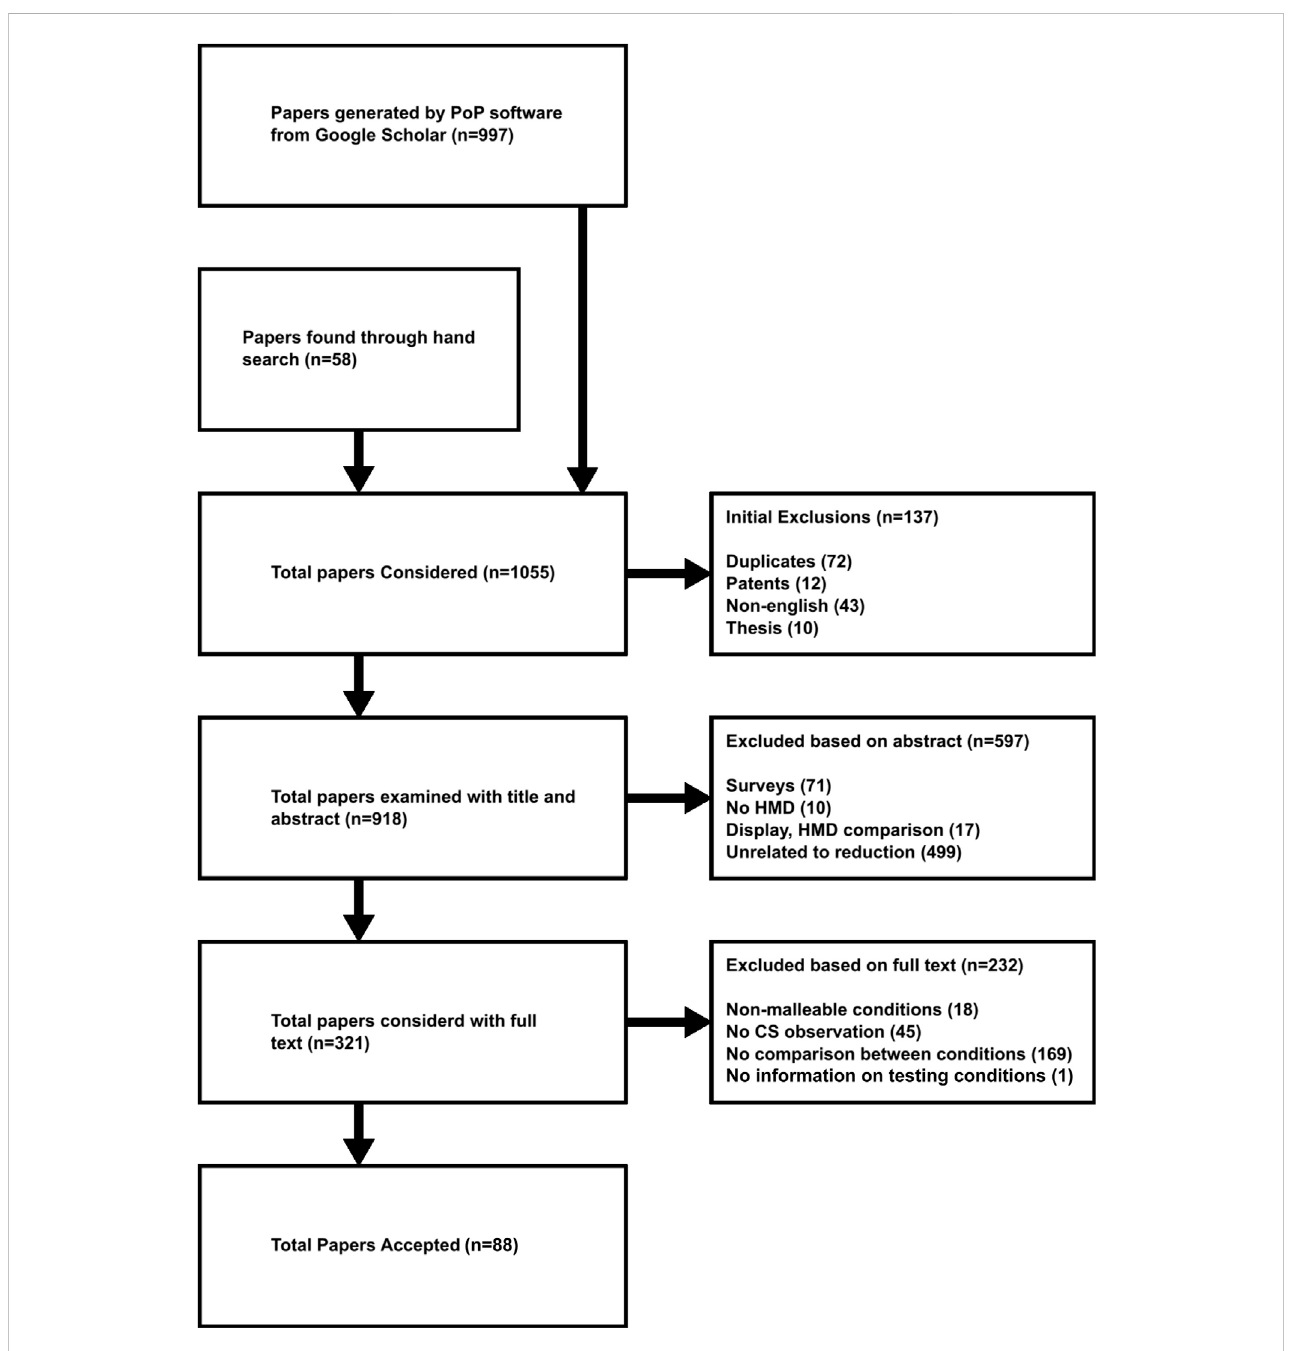
The selection process of papers included in this